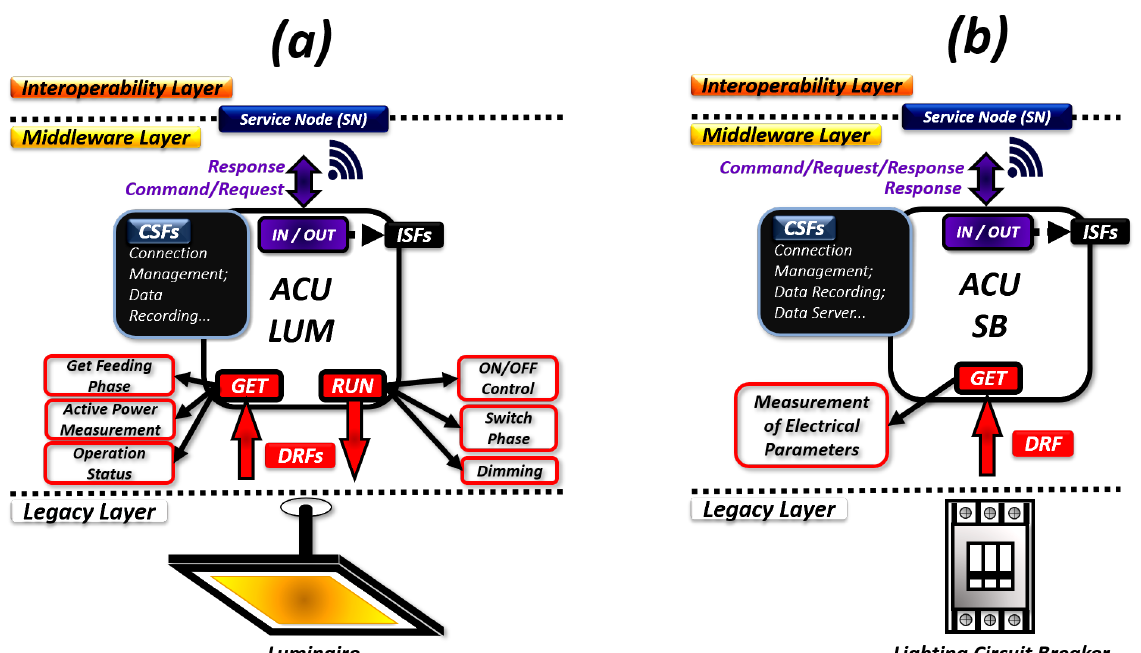
Figure 4. ACU-LUM ( a ) and ACU-SB ( b ) architecture